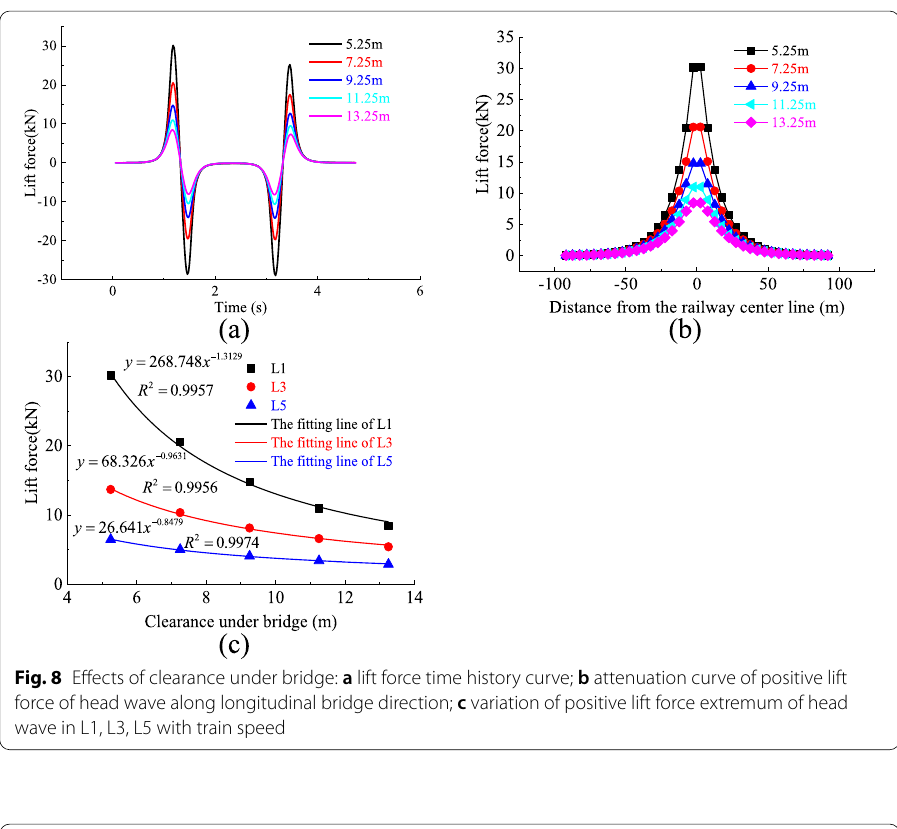
Fig. 8 Effects of clearance under bridge: a lift force time history curve; b attenuation curve of positive lift force of head wave along longitudinal bridge direction; c variation of positive lift force extremum of head wave in L1, L3, L5 with train speed